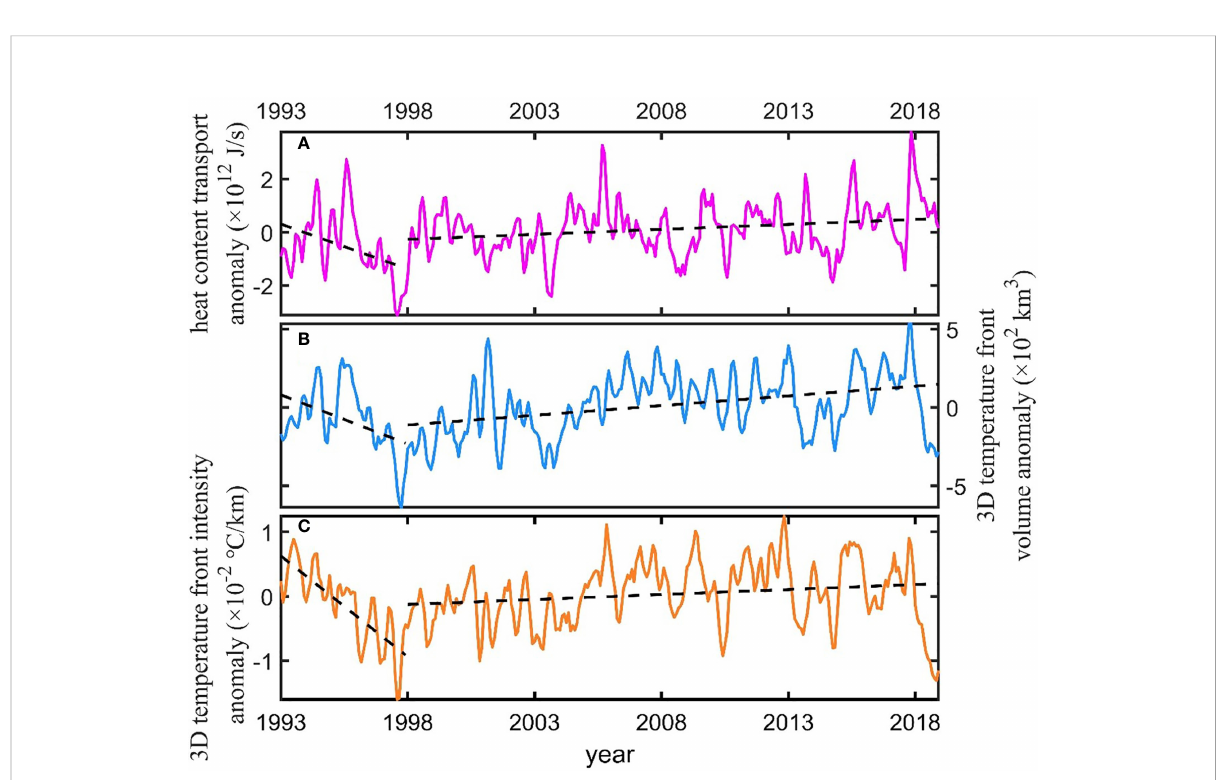
FIGURE 10 Long-term trend. (A) Monthly heat content transport anomaly along the upper 25-m section (red line) indicated in Figure 1A, (B) 3D temperature front volume anomaly, and (C) intensity anomaly. All lines are fi ltered by three (months) points moving